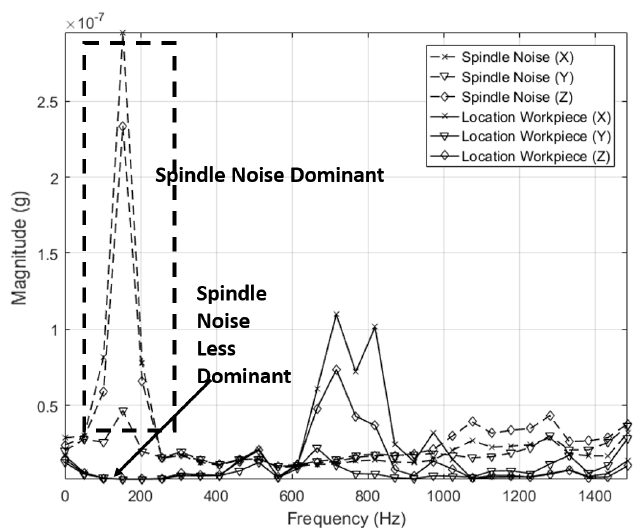
Figure 18. Vibration signal when sensor is placed on (1) Tool and (--) (2) Workpiece (-).